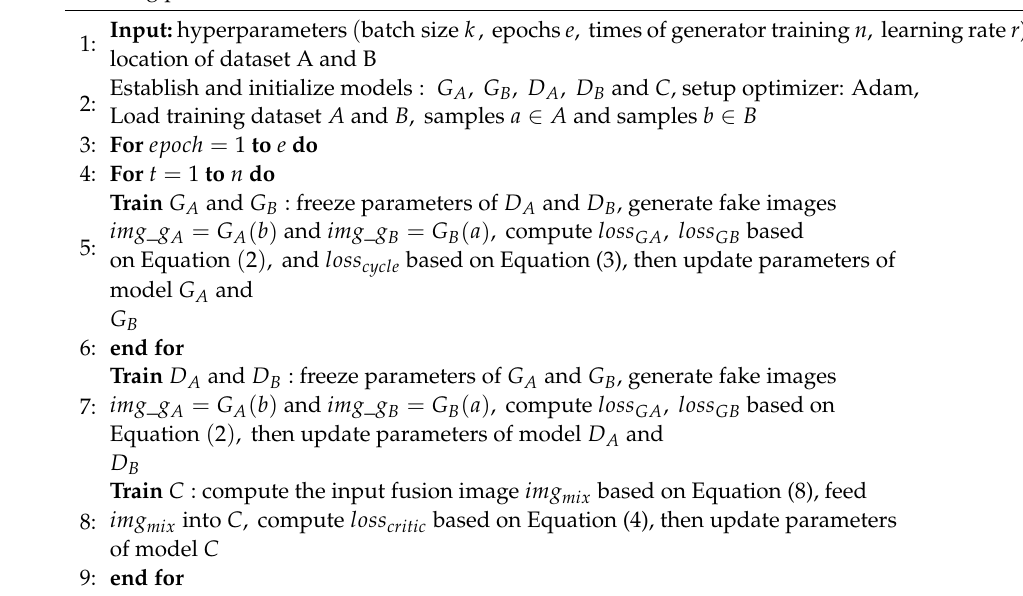
Algorithm 1. MCC-CycleGAN training process. The pseudocode of the proposed network training